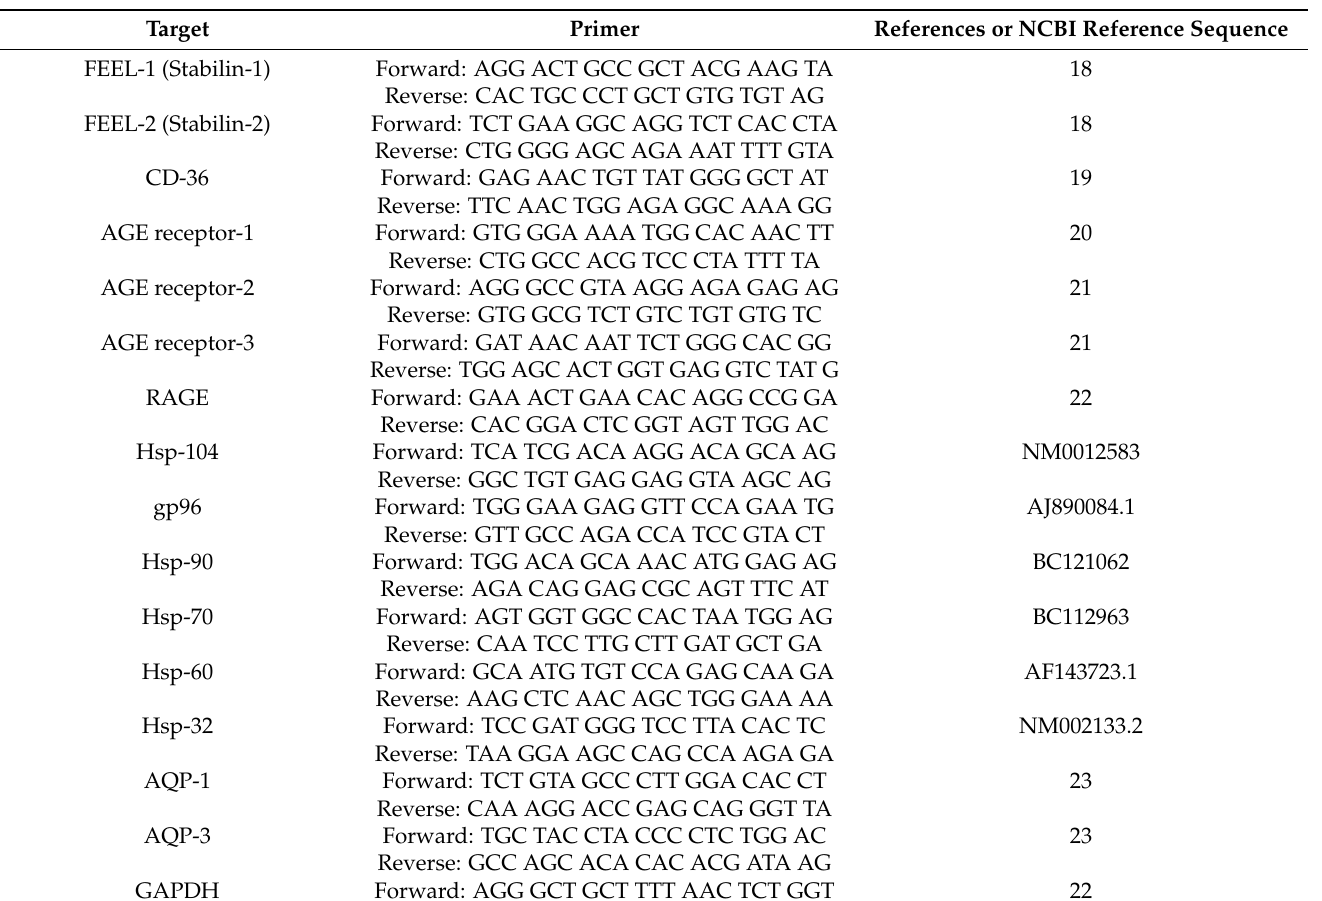
Table 1. Primers for